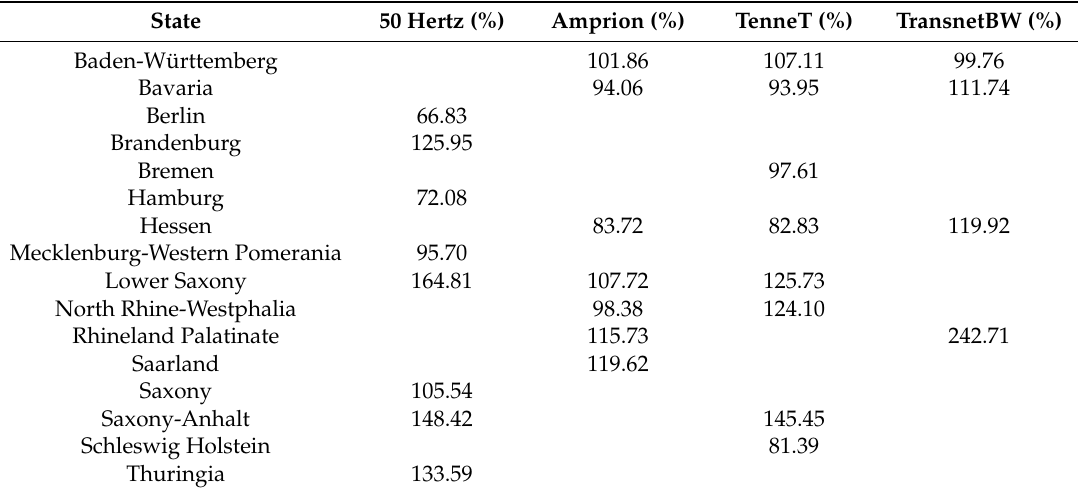
Table 7. The adjustment factors for each state.